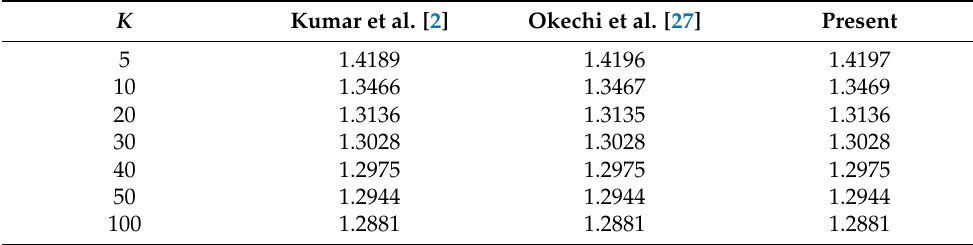
Table 1. Impact of curvature on C f